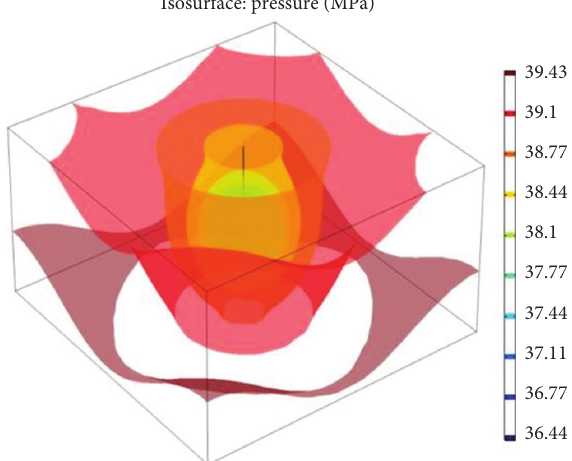
Figure 5: Distribution of 3D pressure field on the 60th